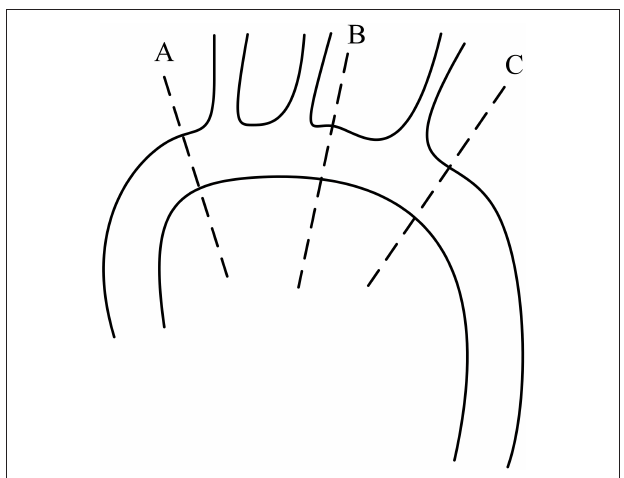
FIGURE 2 | Locations of the measurements in the aorta; level A: 1cm proximal to the innominate artery; level B: 1cm distal to the left common carotid artery; and level C: 1cm distal to the left subclavian